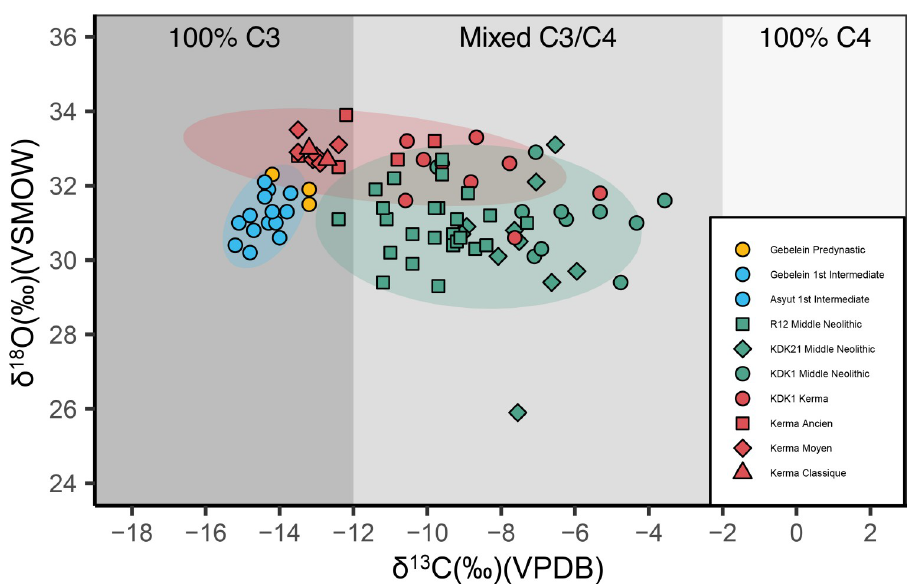
Fig 14. δ 13 C and δ 18 O carbonate measurements of humans from this study and relevant Egyptian and Upper Nubian Nile Valley sites prior to New Kingdom conquest 1500 BCE. Refer to S28 Table in S1 File for mean values. Gebelein and Asyut [53], R12 [50], Kerma Ancien , Moyen and Classique refer to Eastern Cemetery individuals [52]. Shading indicates estimated carbonate δ 13 C for individuals consuming 100% C 3 , mixed C 3 /C 4 , and 100% C 4 sources